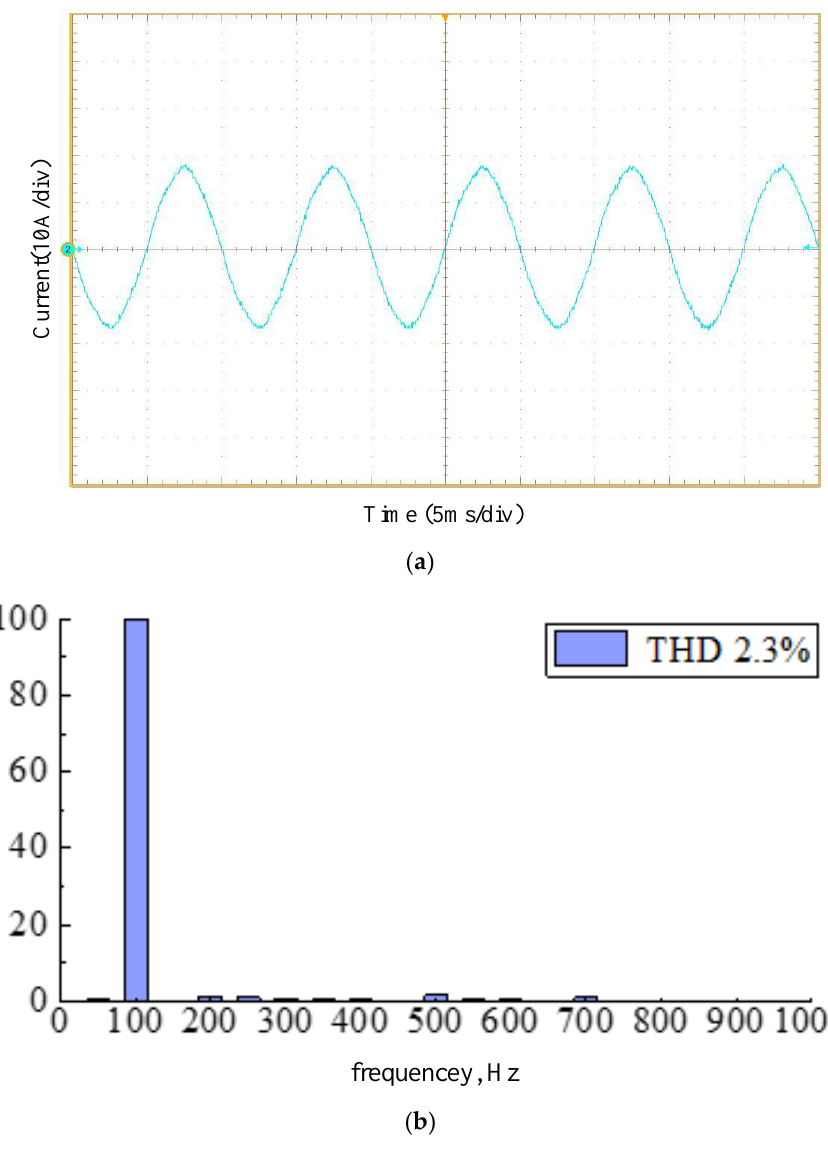
Figure 22. Improved DTC current experimental waveform. ( a ) Improved DTC current experimental diagram. ( b ) Improved DTC current FFT analysis diagram.